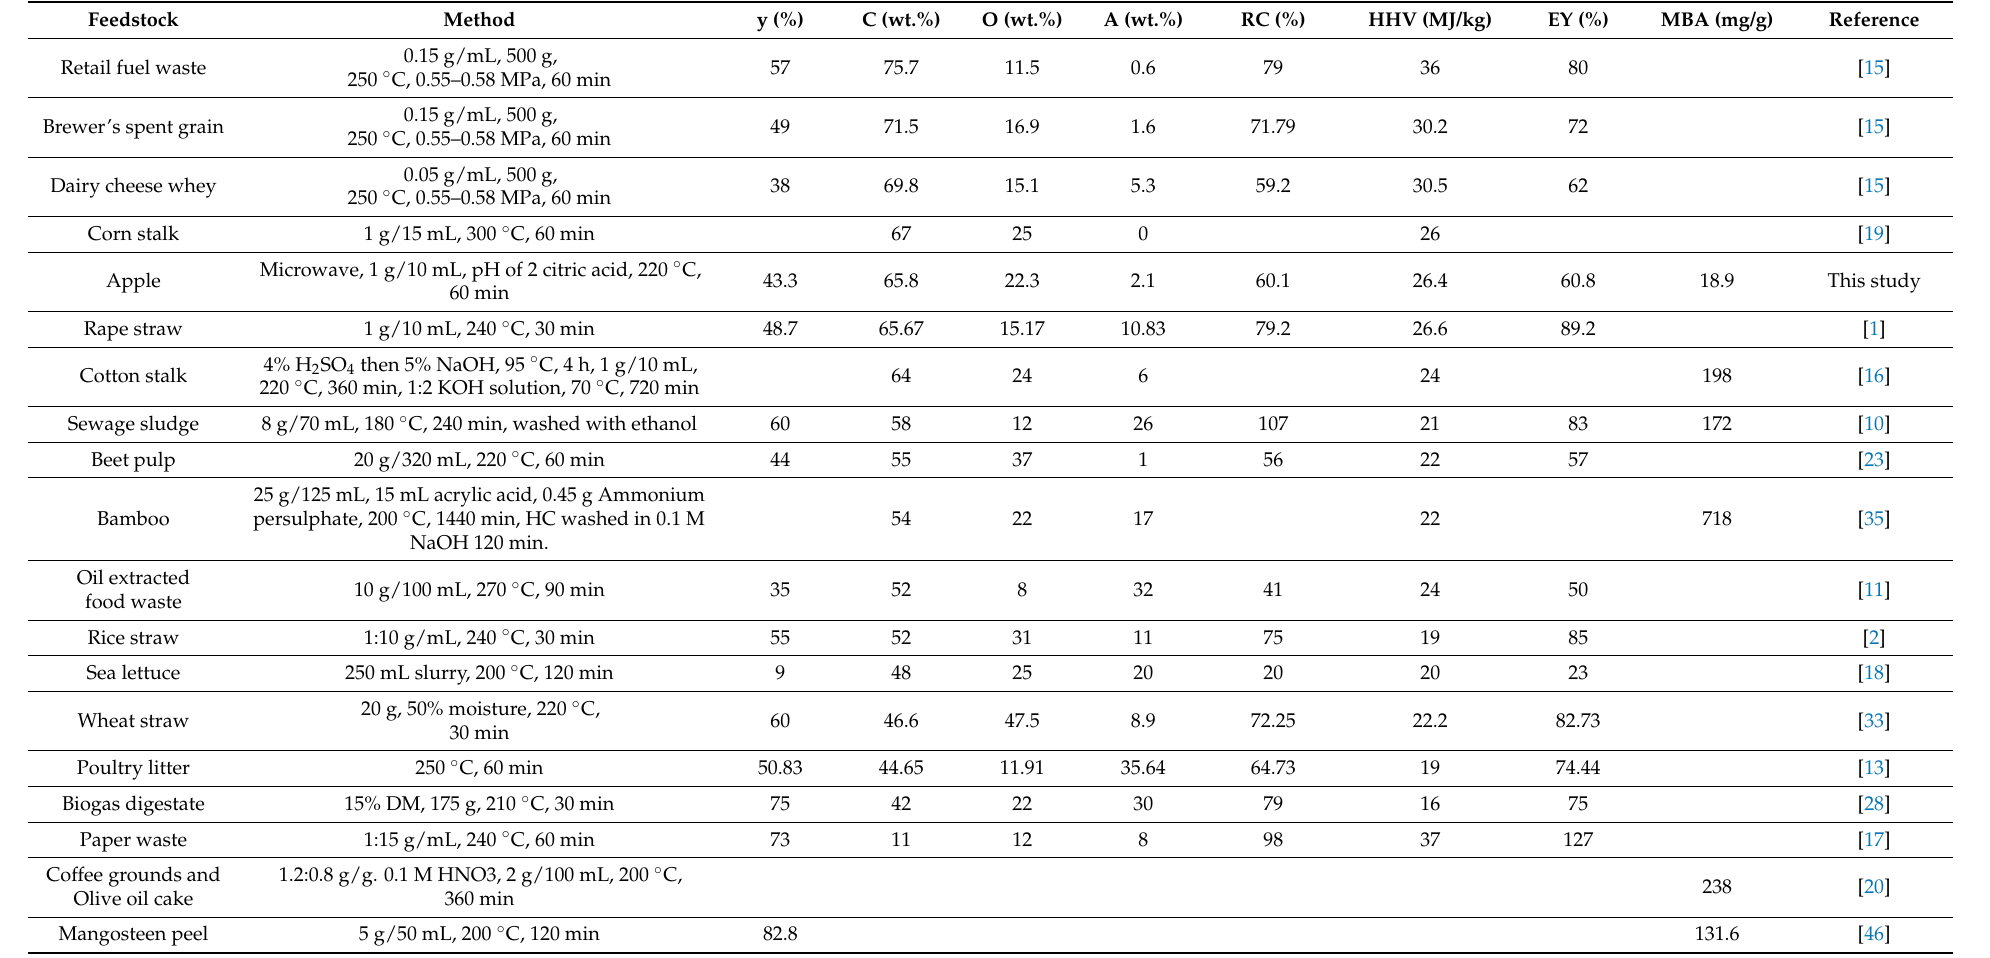
Table A6. Comparison of recent methods to produce HC and